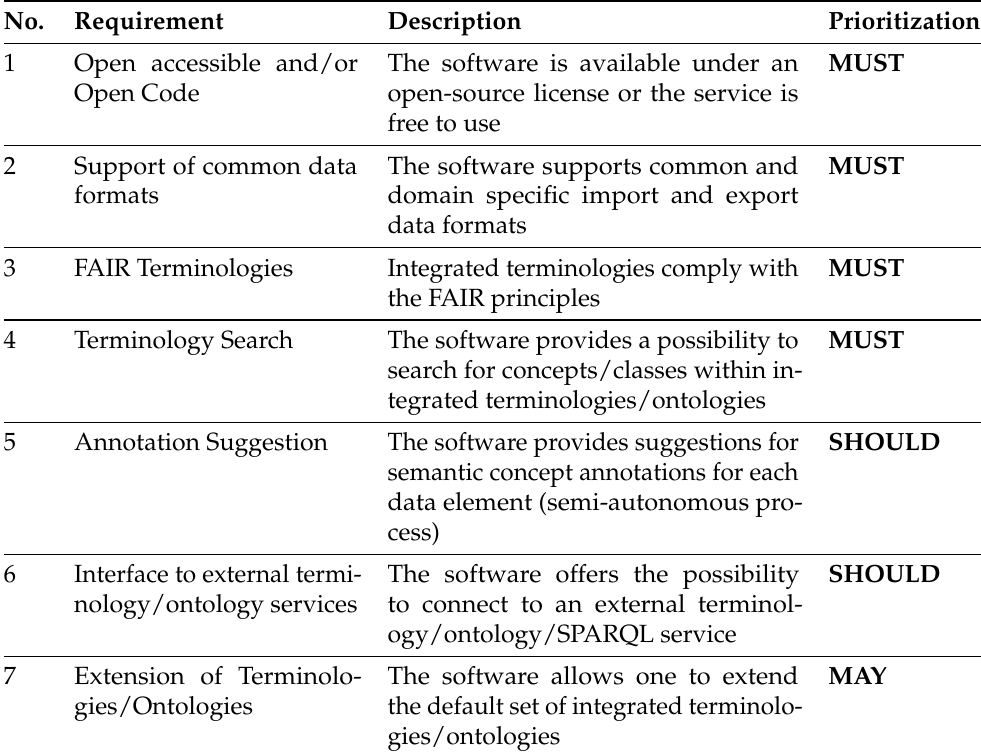
Table 1. Requirements and their prioritization for a semantic metadata annotation service based on current use cases in the NFDI4Health